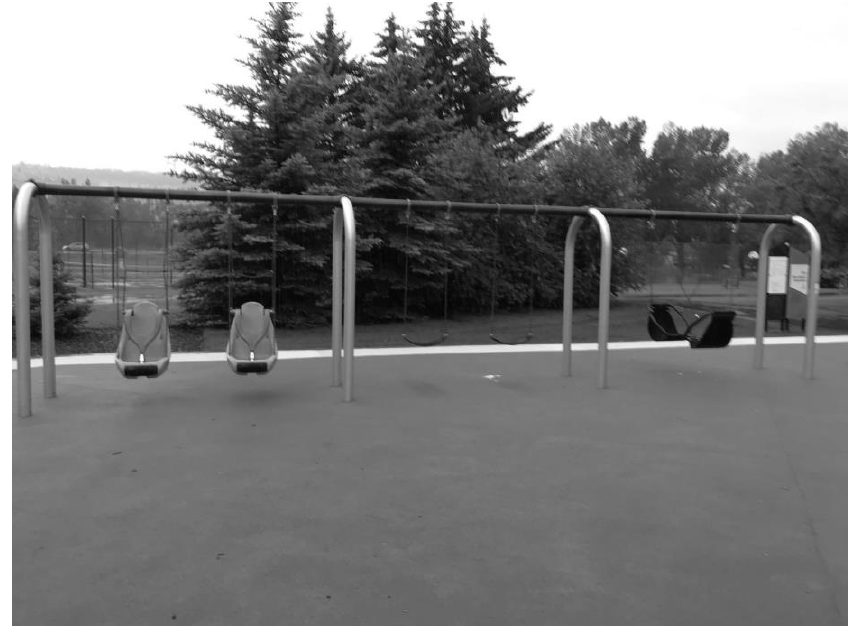
Figure 3. Image depicting part of the freestanding equipment section of the observed playground.